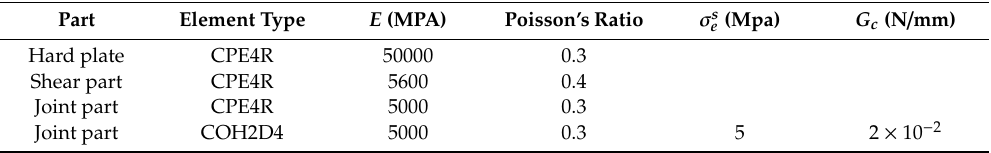
Table 3. Materials properties used for FEM